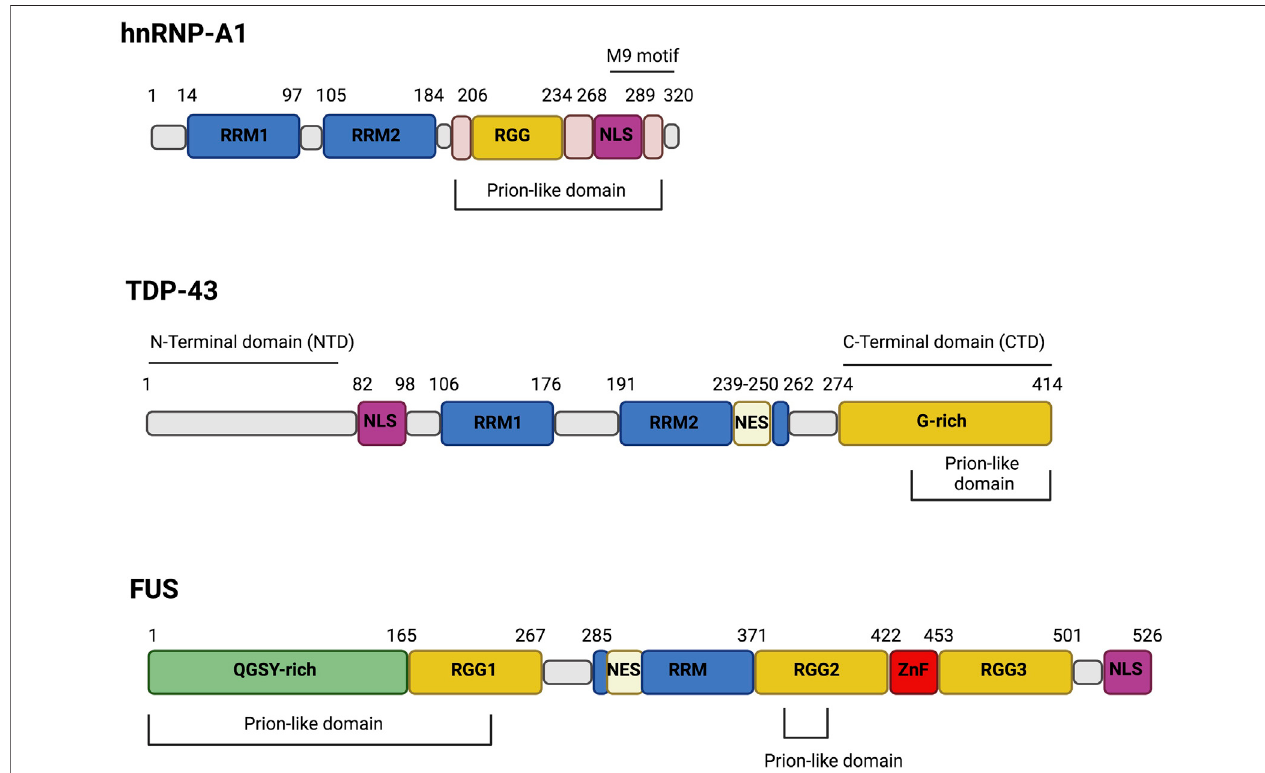
FIGURE1| ThedomainstructureofhnRNP-A1,TDP-43andFUS.TheRNA-bindingproteinshnRNP-A1,TDP-43andFUSsharestructuresimilarities.Particularly, they harbor Prion-like domain, RNA-recognition motif (RRM) and nuclear localization signal (NLS). hnRNP-A1 and FUS are both characterized by the presence of Arg- Gly-Gly-rich (RGG) domains while TDP-43 has a Gly-rich (G-rich) domain and hnRNP-A1 display a M9 motif. Moreover, both FUS and TDP-43 present nuclear export signal (NES) but only FUS has a zinc- fi nger (ZnF) domain and a Gln-Gly-Ser-Tyr-rich (QGSY-rich) domain.